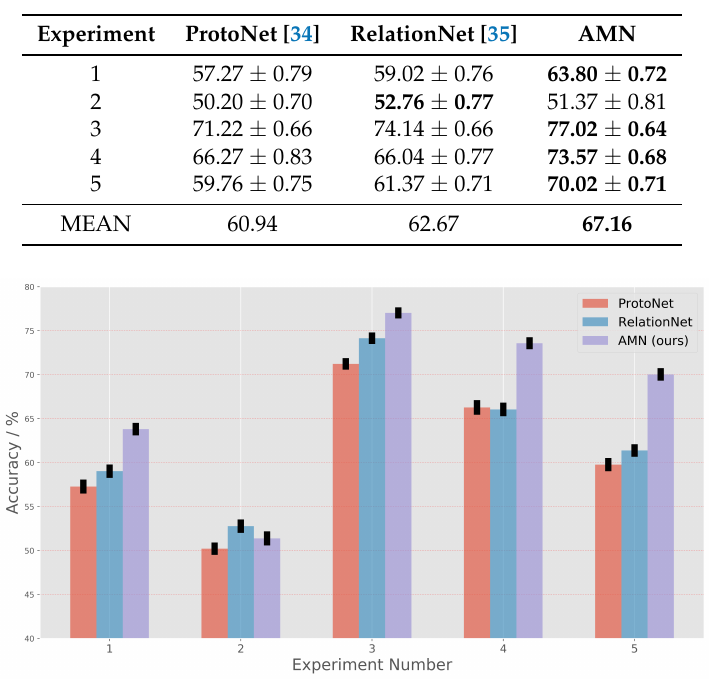
Figure 9. Experimental results on the NWPU-RESISC45 dataset, each experiment contains 600 randomly selected